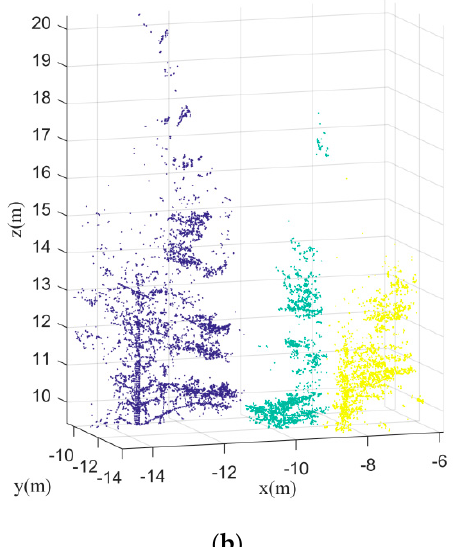
Figure 19. Initial segmentation results for easy and difficult plots. ( a ) Plot 1 scanned in single mode; ( b ) plot 6 scanned in single mode.